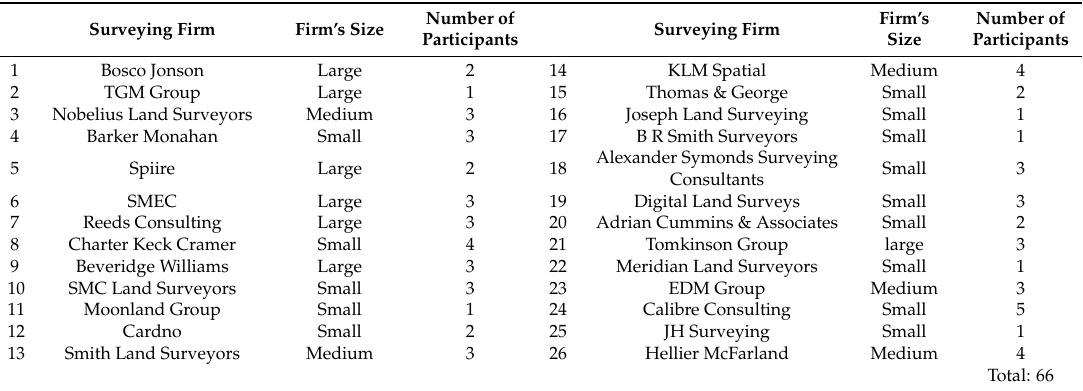
Table 1. Participants of face to face